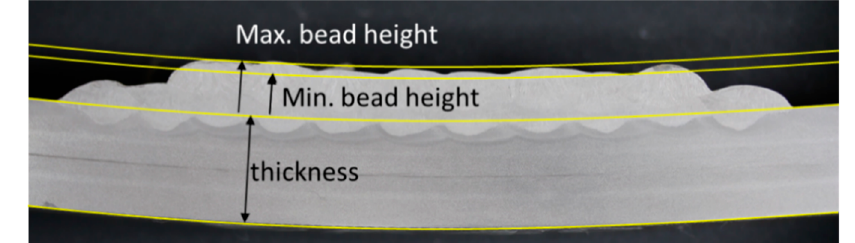
Figure 3. Magnified image of welded sample for welding at 285 A, 29 V, and 30 cm/min.